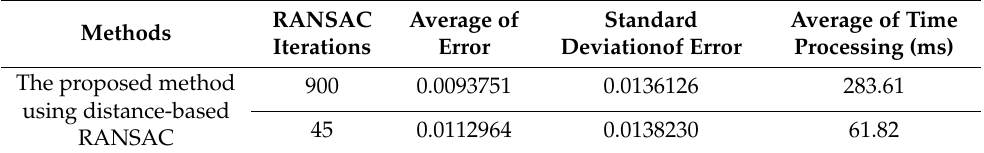
( b ) Figure 8. Detected R-VPs (indicated by red circles) and road boundaries drawing by hand (by white lines) under nighttime conditions using the proposed method applying reduction of type 2 and type 3, using ( a ) RANSAC iteration 900 and ( b ) iteration 45.